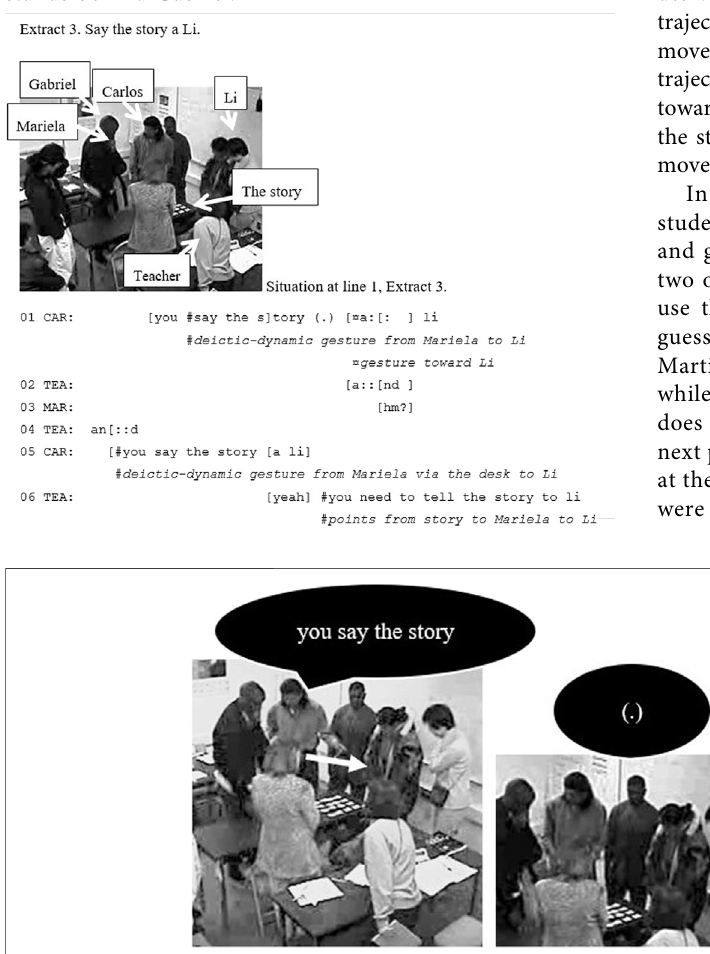
FIGURE 5 | Extract 3. line 1. (Arrows marking the trajectory of carlos ’ hand